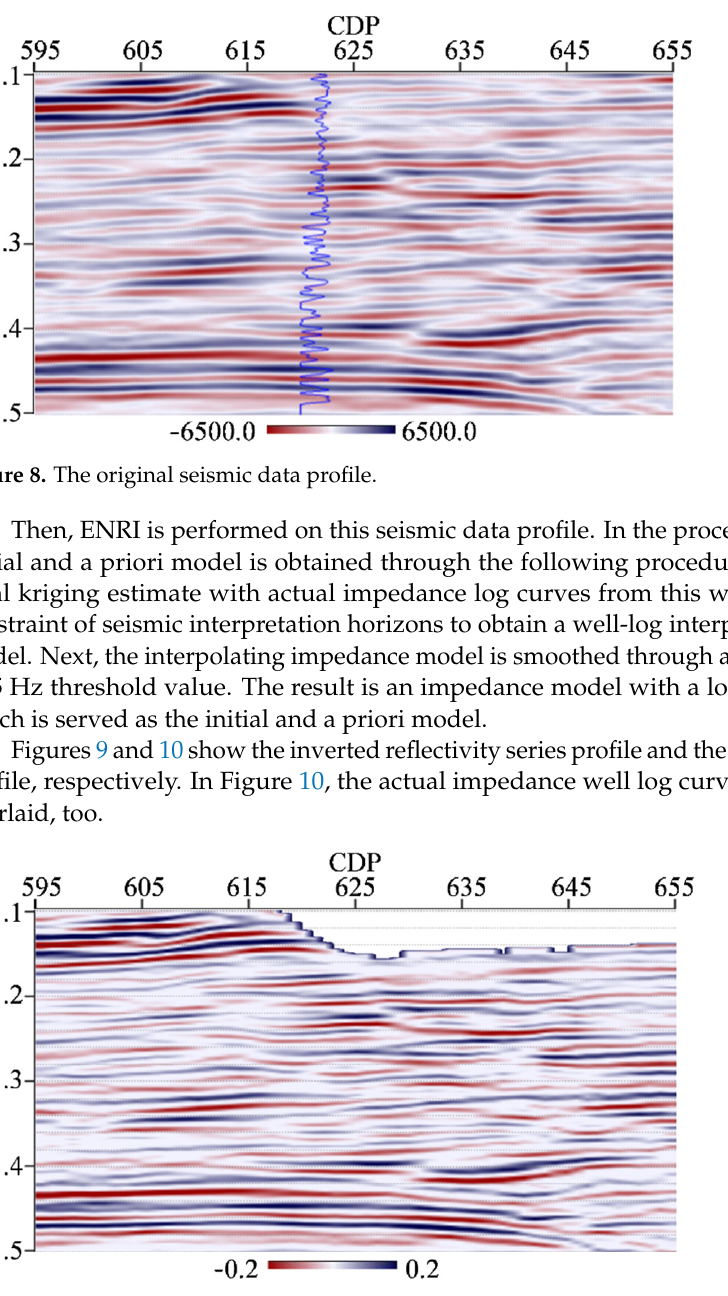
Figure 8. The original seismic data profile.